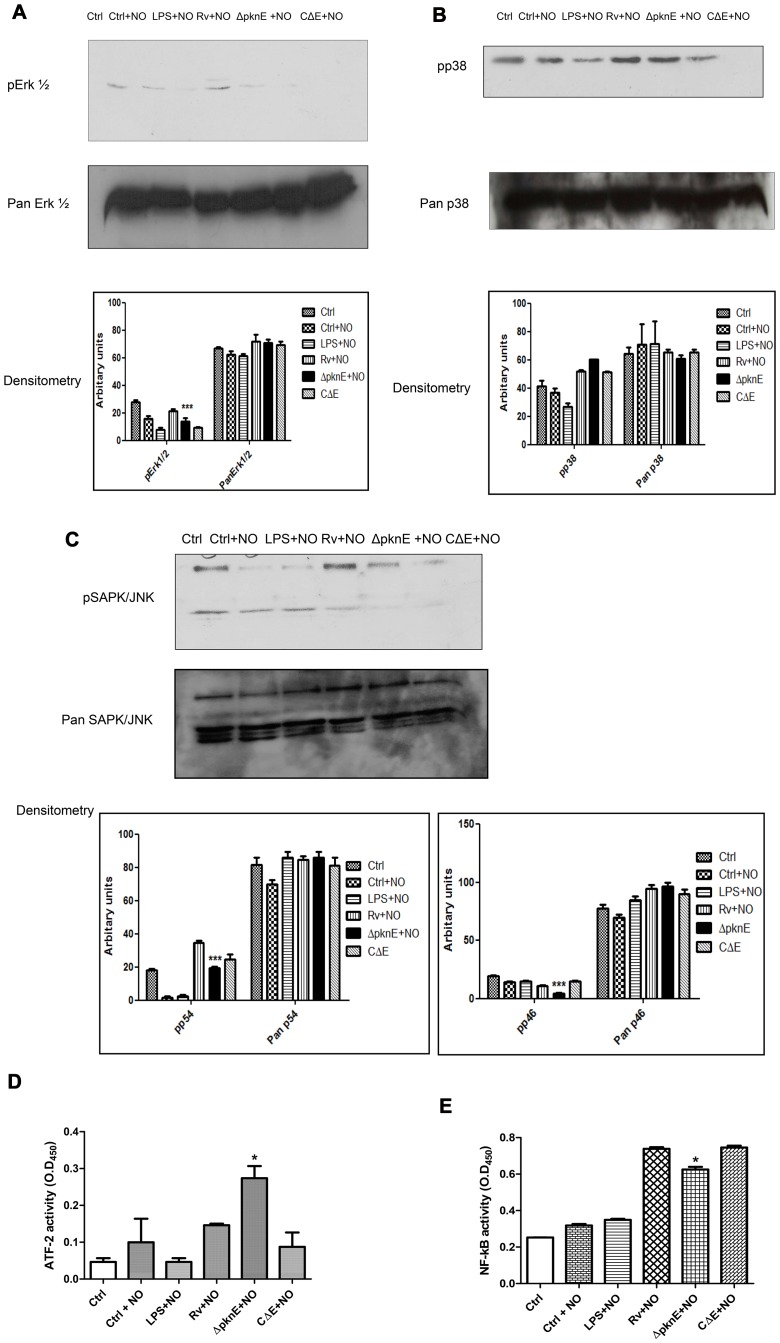
ΔpknE infected macrophages show defective MAPK signaling in the presence of NO stress.Controls (ctrl, LPS) and infected cells were lysed post NO stress and subjected to western blotting. The blots were probed with phospho A) Erk1/2, B) p38, and C) SAPK/JNK with their respective non phospho antibodies and the results of three independent experiments are given. The corresponding densitometry values of phospho and nonphospho are given at the end of antibody probed blots. *** denotes p<0.0001, when ΔpknE infected macrophages compared with Rv (one – way ANOVA). The abbreviations ctrl denotes control, LPS denotes lipopolysaccharide, and NO denotes nitric oxide. Nuclear fractions isolated post infection was subjected to DNA binding ELISA D) ATF-2 and E) NF-kB. The results are from three independent experiments. The error bars denote standard error of the means. * denotes p<0.05 (one way ANOVA) when ΔpknE+NO was compared to Rv+NO treated macrophages.